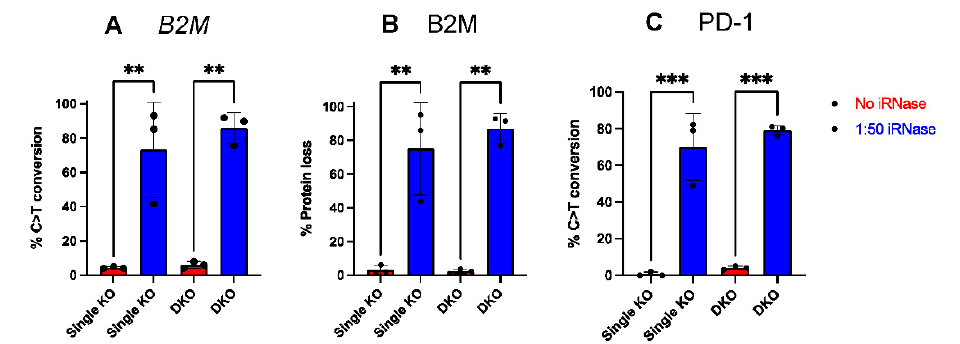
Figure 5. iRNase allows Base editor mRNA for efficient single or multiple genes KO in monocytes. Percent of ( A ) B2M protein loss as measured by flow cytometry, ( B ) percent of C > T conversion at the B2M locus, ( C ) and percent of C > T conversion at the PD1 locus in monocytes following editing with Base Editor mRNA with gRNA(s) target either B2M or PD1 single KO, or double KO along with or without iRNase. Statistical analyses were performed using Student’s t -test (n = 3 independent biological donors) (** p < 0.01, *** p < 0.001).